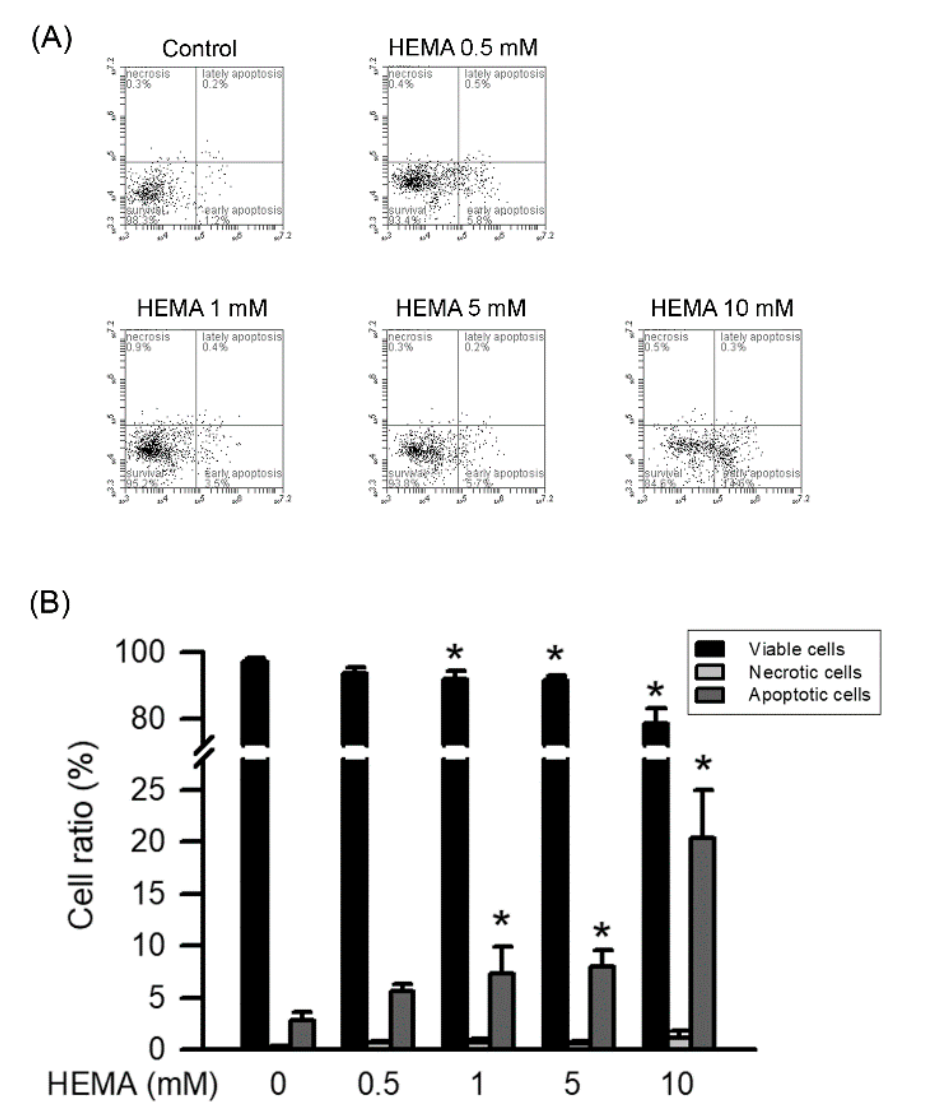
Figure 2. HEMA induced apoptosis in RAW264.7 cells. After treatment, RAW264.7 cells were collected, stained with Annexin V-FITC and PI, and then analyzed by dual-staining flow cytometry. ( A ) Representative FACS plot of RAW264.7 macrophages incubated with HEMA. ( B ) Quantitatively, the percentage of viable cells (black column), necrotic cells (gray column), and apoptotic cells (dark gray column) was calculated and analyzed. Data are expressed as mean ± SD. The number of parallel measurements is 4. * means that p < 0.05 compared with HEMA at the concentration of 0 mM.